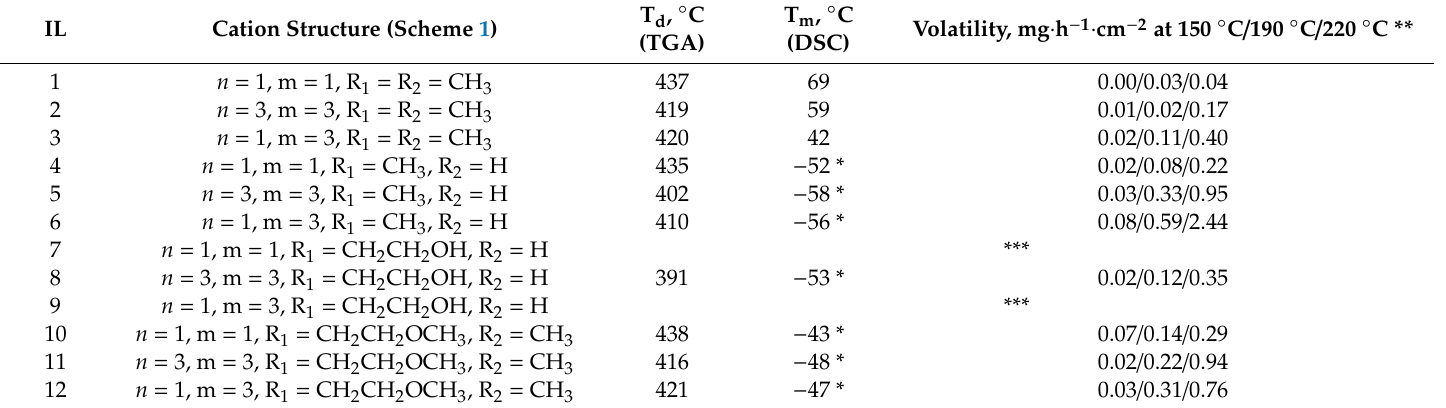
Table 1. The properties of disiloxane dicationic ionic liquids 1–12 with bis(trifluoromethylsulfonyl)imide